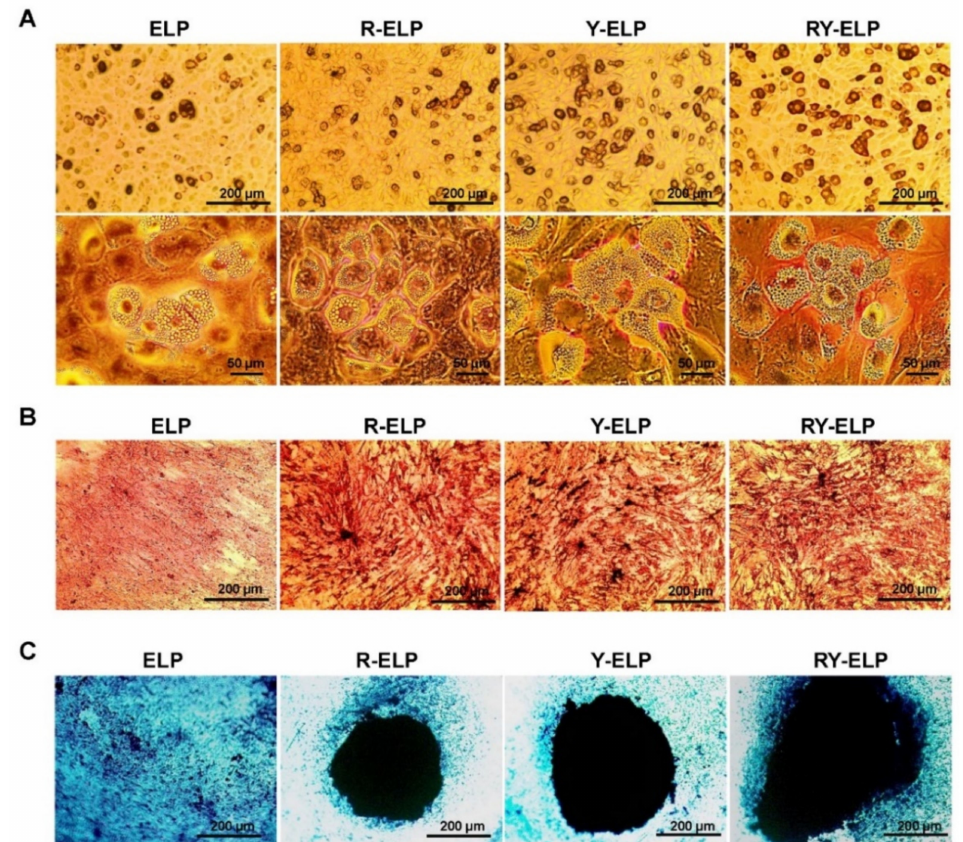
Figure 9. Trilineage differentiation in ELP matrix. ( A ) Adipogenesis was confirmed by cytochemical staining with Oil Red O to visualize lipid droplet formation ( n = 3). ( B ) Osteogenesis was confirmed by cytochemical staining with Alzarin Red to visualize calcium nodule formation on fusion-ELP- coated surface compared with uncoated surface ( n = 3). ( C ) Chondrocyte differentiation of MSCs on fusion-ELP-coated plates were visualized by Alcian Blue staining compared with uncoated control ( n = 3), Scale bars: 200 µ